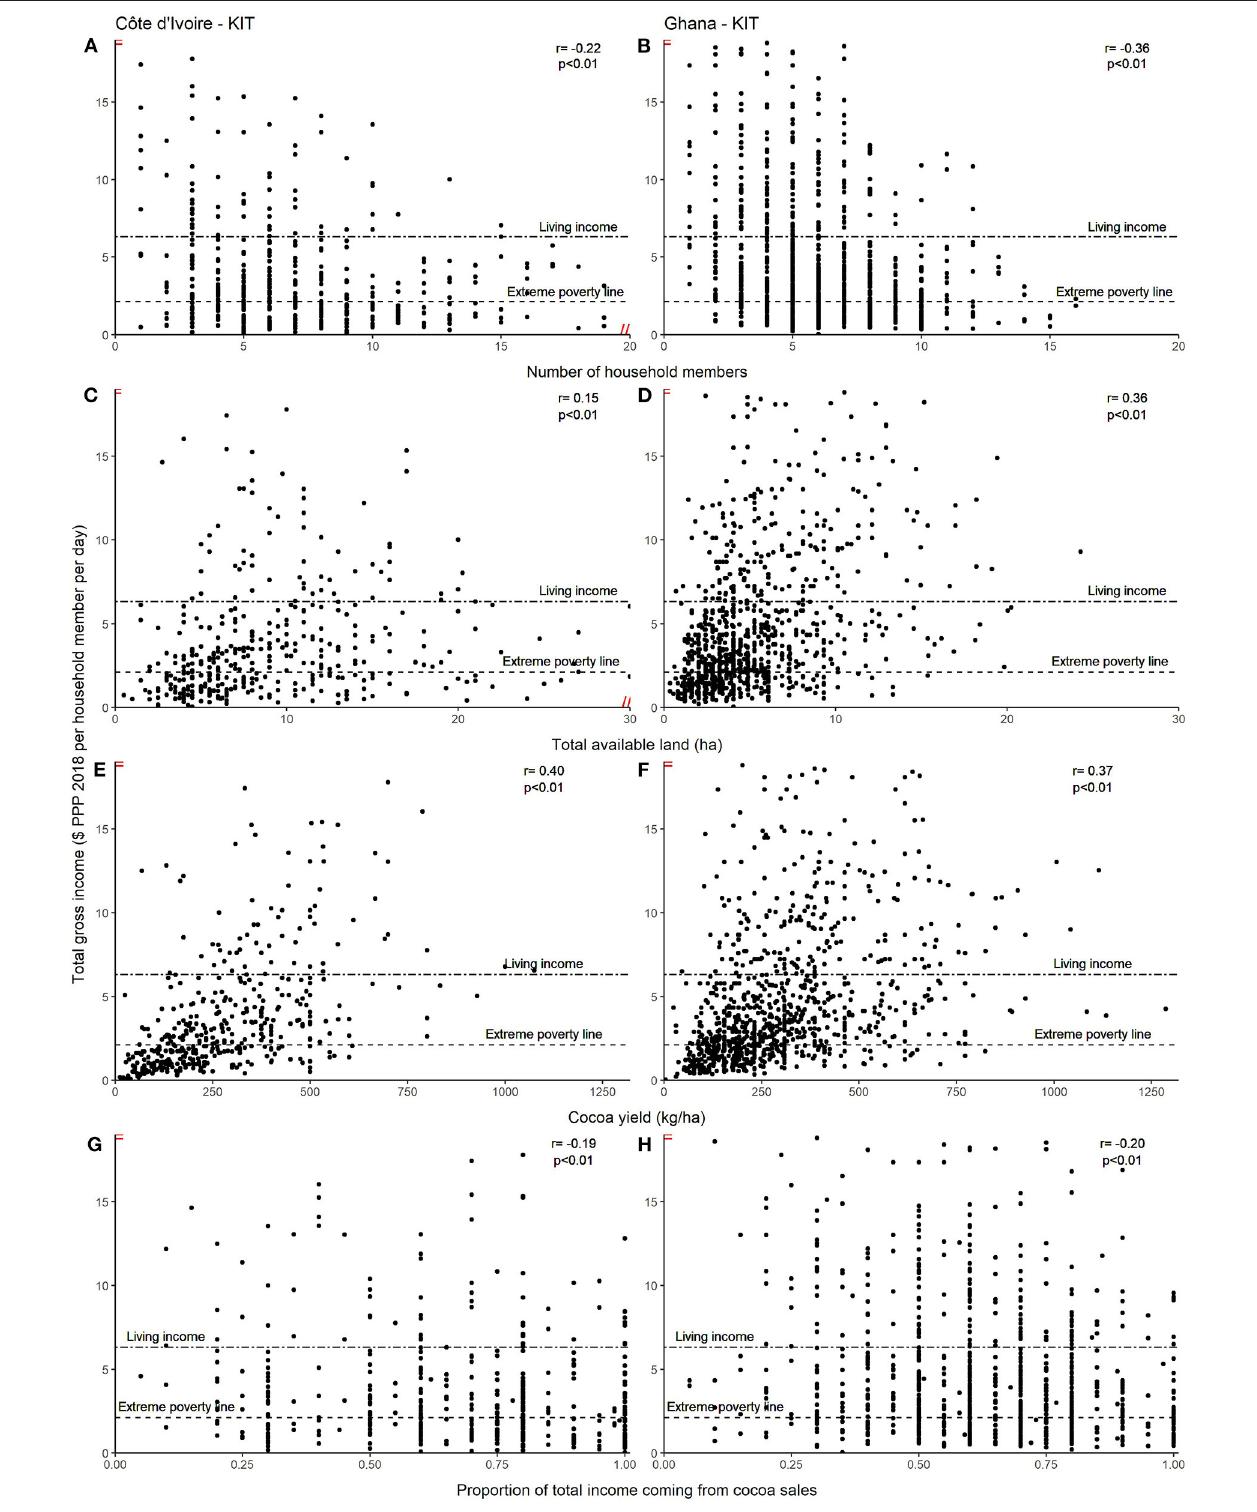
FIGURE 3 | Scatter plots of number of household members (A,B) , total available land (ha; C,D ), cocoa yield (kg/ha; E,F ), and proportion of total income coming from cocoa sales (G,H) over total gross income per household member per day based on data from KIT. r-values are Pearson correlations for each variable with income